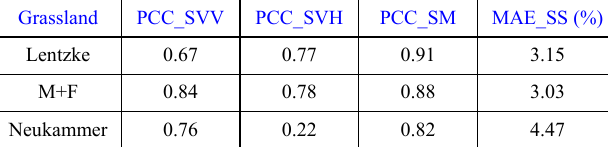
Table 1. Comparison between measurement and evaluation. PCC_SVV, *_SVH, and *_SM: PCC of measured soil moisture to VV-polarized Gamma Naught, VH-polarized Gamma Figure 9. Comparison of soil moisture and SBAS-derived Naught, and SBAS-movement. MAE_SS, mean absolute error movement at Neukammer (Figure 3). between measured and predicted soil moistures (via respective forward models).